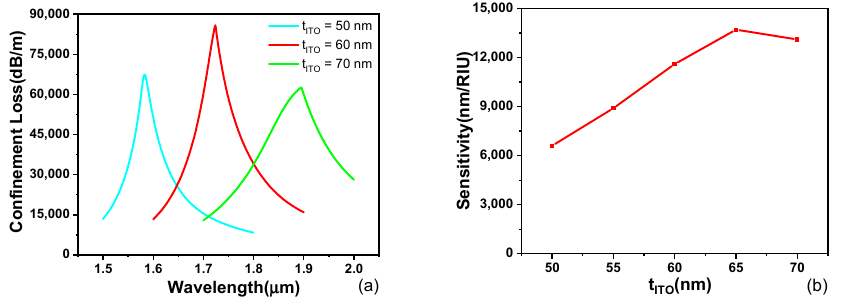
Figure 6. The loss spectrum ( a ) and sensitivity ( b ) for different ITO film thickness t ITO . The remaining parameters are d = 1.6 μ m, d 2 = 1 μ m, h = 6.4 μ m, and n a = 1.38.